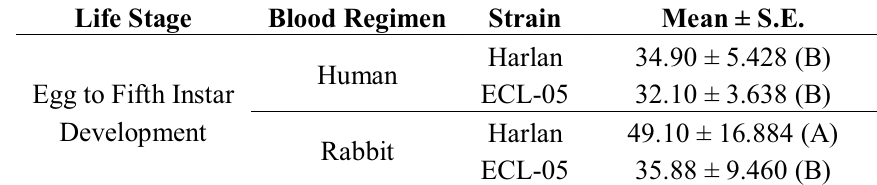
Table 8. Mean development time (in days) of (laboratory strain) HS and ECL-05 bed bugs reared on two different blood